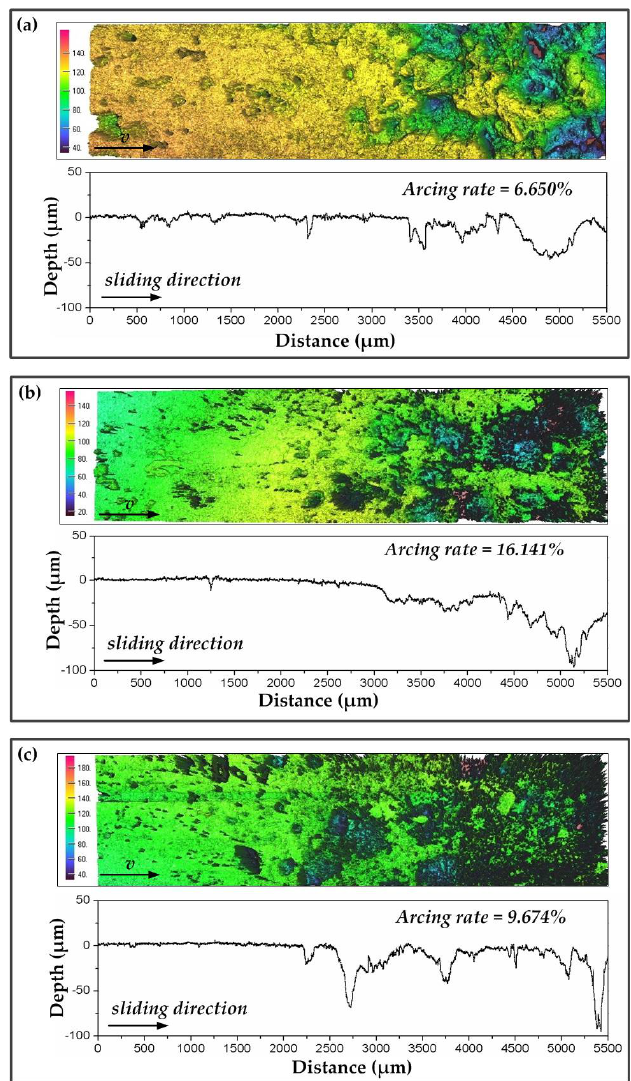
Figure 9. 3D surface morphology ( top ) and surface roughness profiles ( bottom ) of the strip after testing for 40 s at 100 km·h −1 , 120 A: ( a ) B = 8 N; f = 0.426 Hz; ( b ) B = 41 N, f = 0.426 Hz; ( c ) B = 41 N, f = 0.169 Hz.